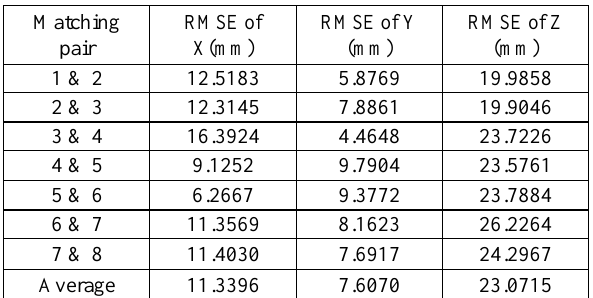
Figure 5. Source Images